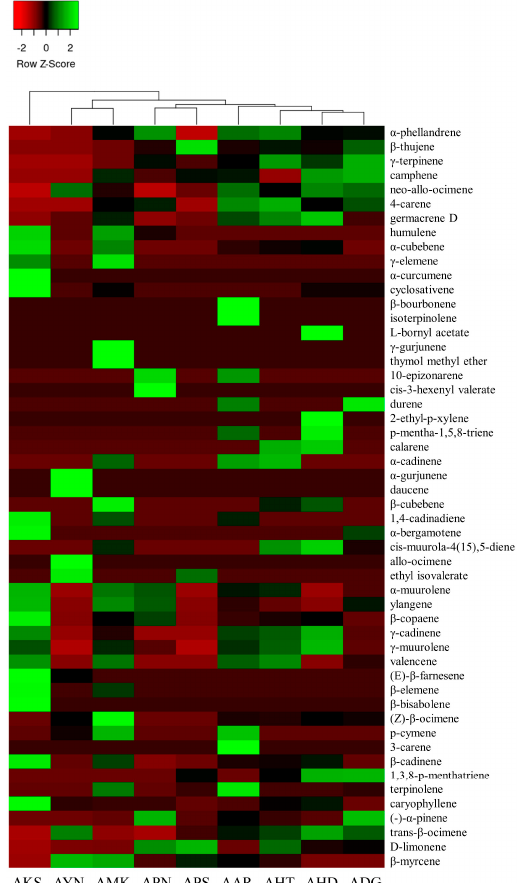
Figure 5. Heat map analysis of the relative content of volatile components in nine Aster species. The color scale represents the scaled abundance of each Aster species, with green and red colors representing high and low contents, respectively.